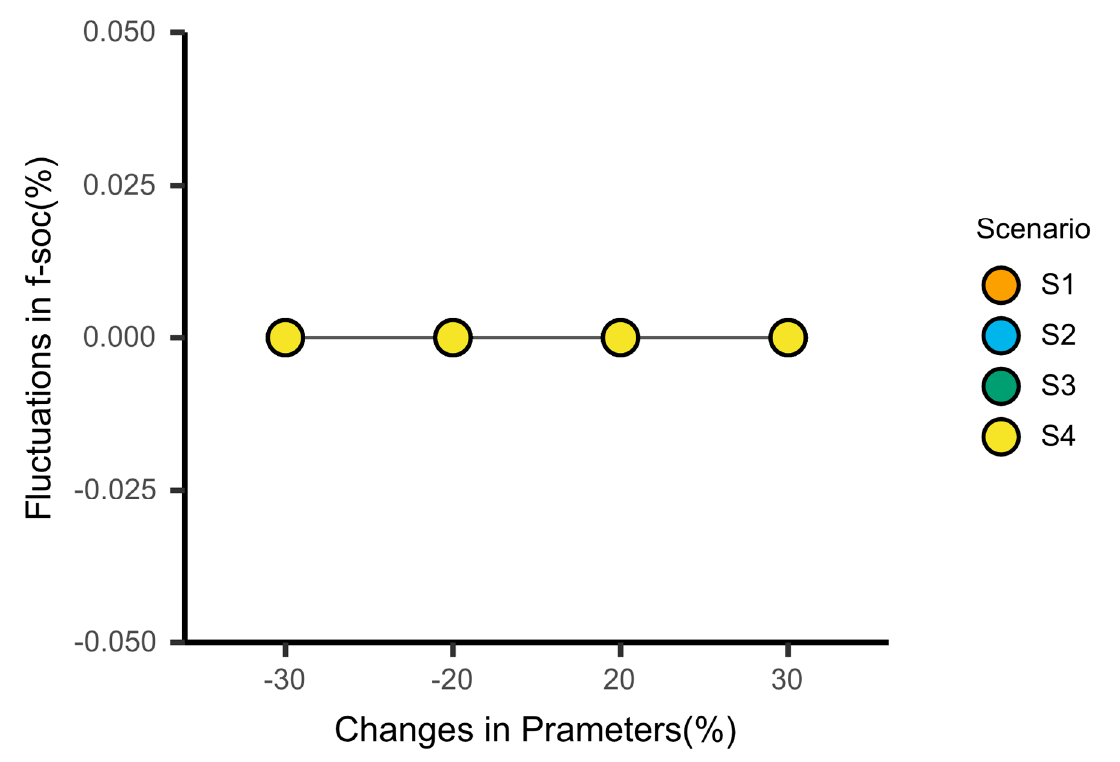
Figure 8. Sensitivity analysis of the f env by changing parameters.